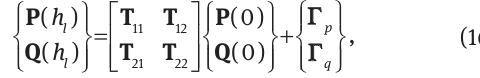
Figure 3 Programming flowchart of the direct coupling displacement vectors, respectively, relative to the top μ -th sublaminate.